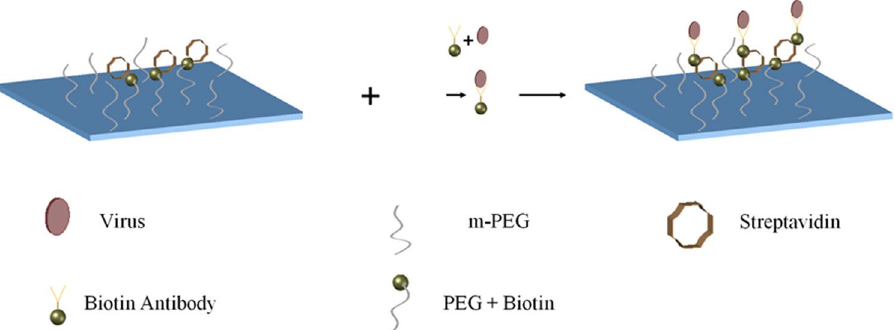
Figure 2. Schematics of the virus capture steps. ( a ) The chip for specific capture of HSV-1 particles is prepared by coating a glass substrate with streptavidin and poly-ethylene-glycol. ( b ) HSV-1 particles in solution are conjugated with biotin tagged antibodies and added onto the substrate. ( c ) HSV-1 particles captured on the substrate are then imaged by our computational holographic microscope for counting their density (counts/mm 2